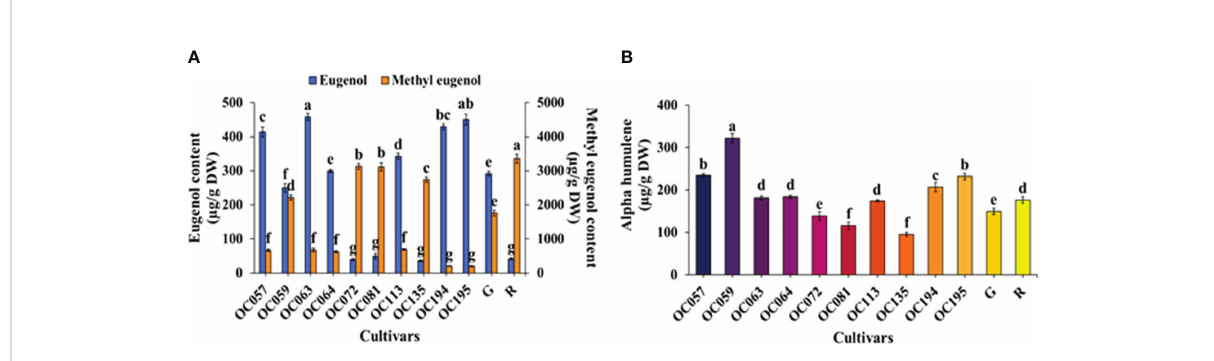
FIGURE 7 The content of eugenol and methyl eugenol (A) and a -humulene (B) among Thai holy basil cultivars/accessions at the fl owering stage. R and G represent the red and green commercial cultivars, respectively. Values are represented as mean ± SE ( n = 4). ANOVA was performed, followed by a mean comparison with DMRT. Letters above bars show the signi fi cant difference of means at P <